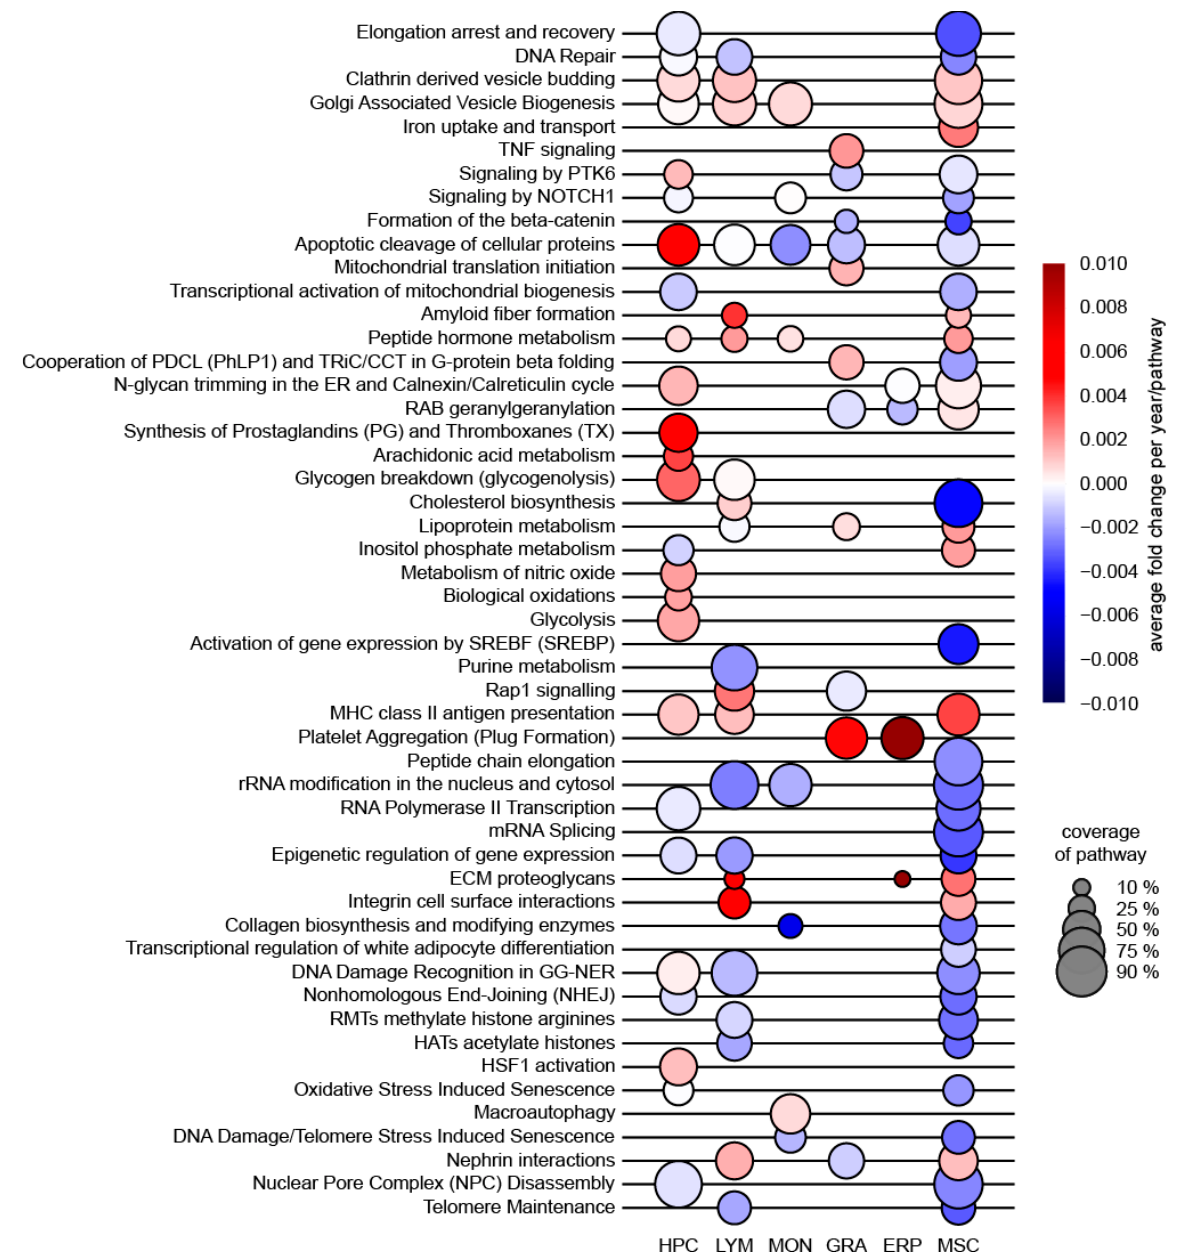
Figure 1. Prominent proteome changes upon aging in six individual cell types in human bone marrow (modified from Hennrich et al. [23]). Selected pathways that were significantly altered, i.e., either up- or downregulated with age are depicted. The size of each circle represents the percentage coverage of a pathway with proteins assessed by LF quantification in our dataset. The color indicates the direction of change, with red being upregulated and blue being downregulated with age.